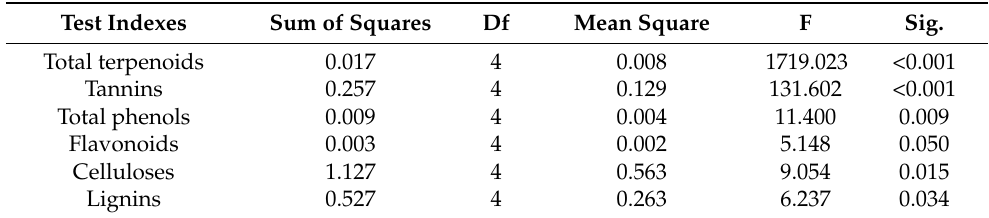
Table 3. One-way ANOVA of insect-resistant compounds in hazelnut shells of different hazel cultivars after chewing by C.